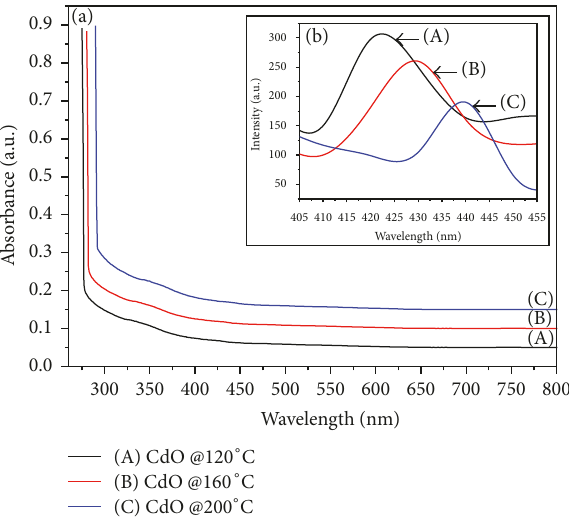
Figure 2: Absorption (a) and emission (b) spectra of HDA-capped CdO nanoparticles synthesized at 120 (A), 160 (B), and 200 ∘ C (C).